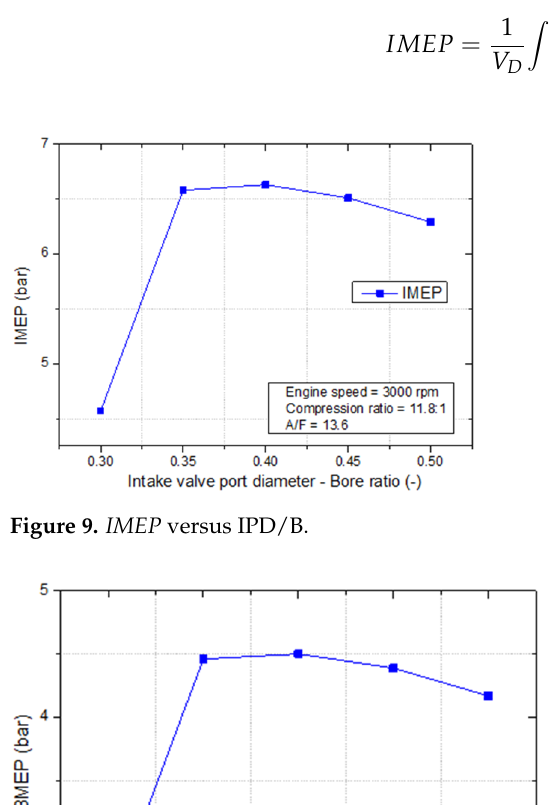
8 of 13 Figure 7. Pressure rise versus IPD/B.